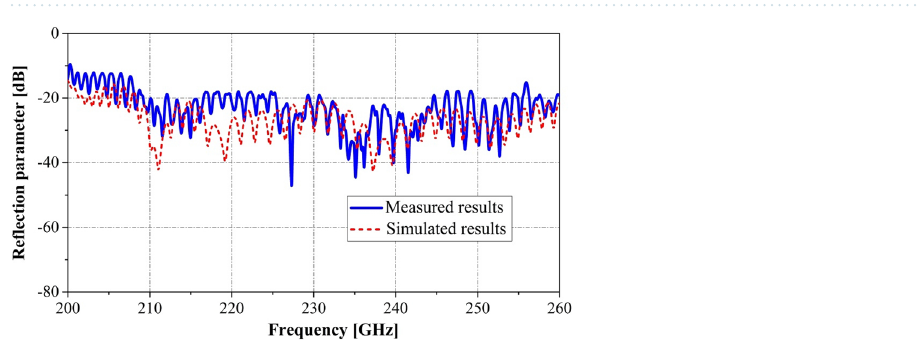
Figure 9. ( a ) Two parts of the fabricated circuit; ( b ) side view of the fabricated circuit; ( c ) the uniform section; and ( d ) the tapered section.